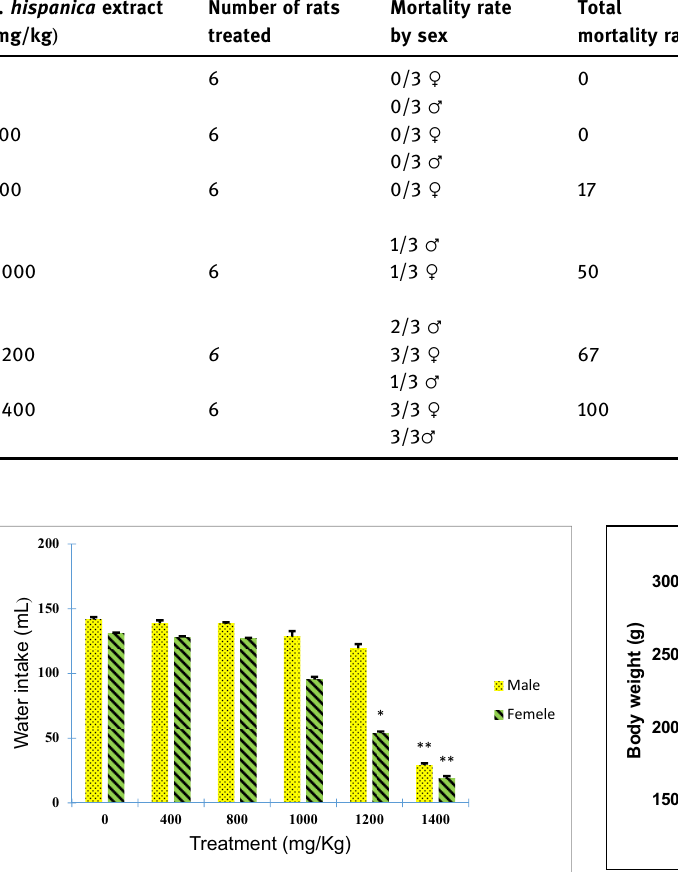
Figure 2: E ff ect of B. hispanica extracts on water intake ( mL/100 g bodyweight ) of animals treated with a dose up to 14,000 mg/kg.